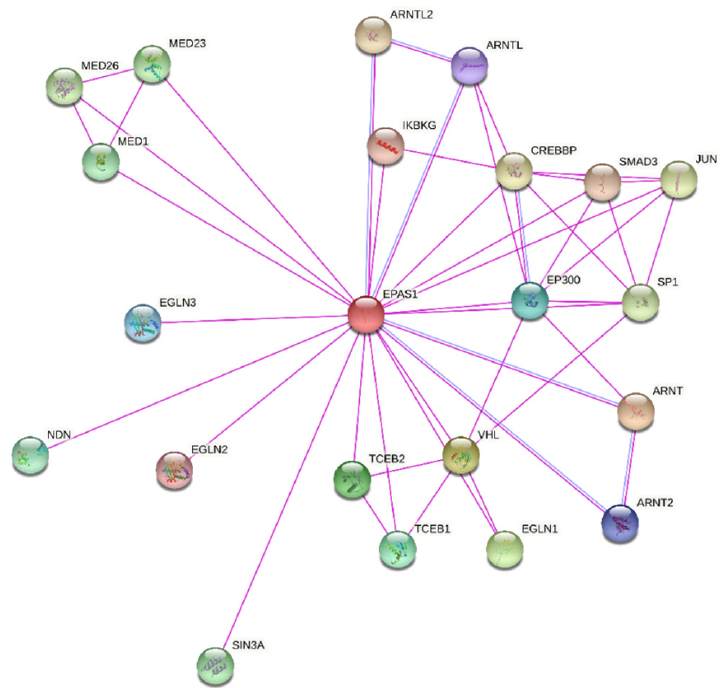
Figure 5. Experimentally determined direct interacting partners of the EPAS1 protein, visualized using STRING tool. Pink lines indicate experimentally determined interactions. Blue lines indicate interactions from curated databases.